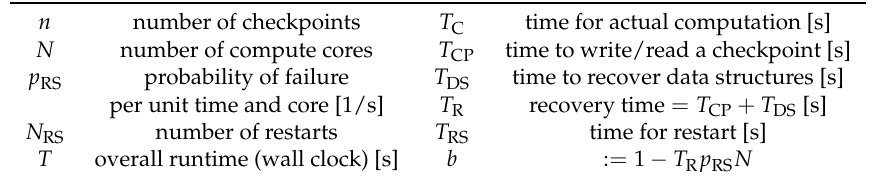
Table 2. Notation used for optimal checkpointing. Where applicable, units are given in brackets.